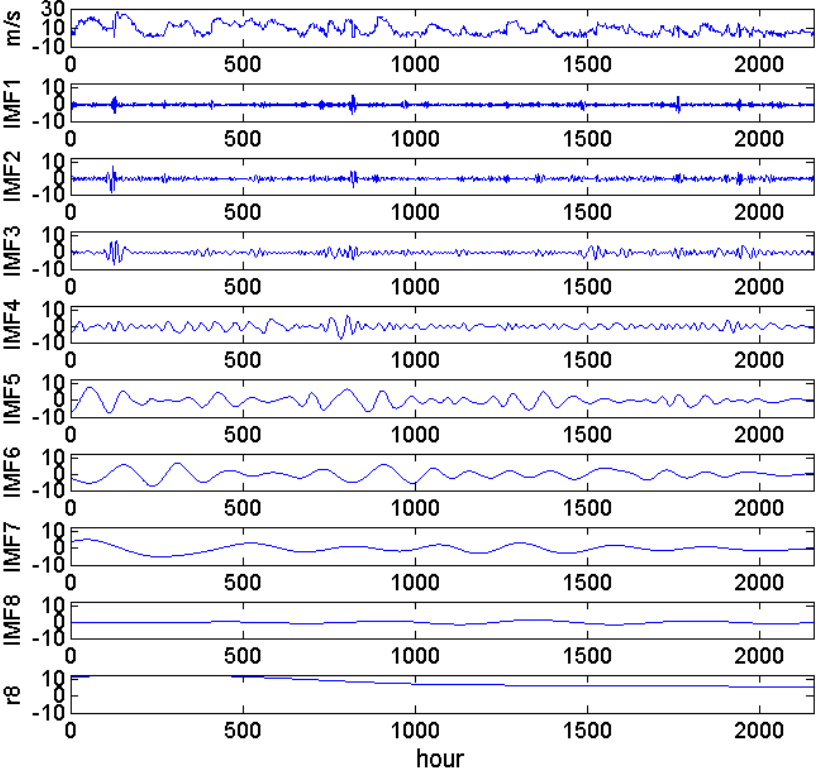
Figure 4. Empirical mode decomposition of wind speed in the